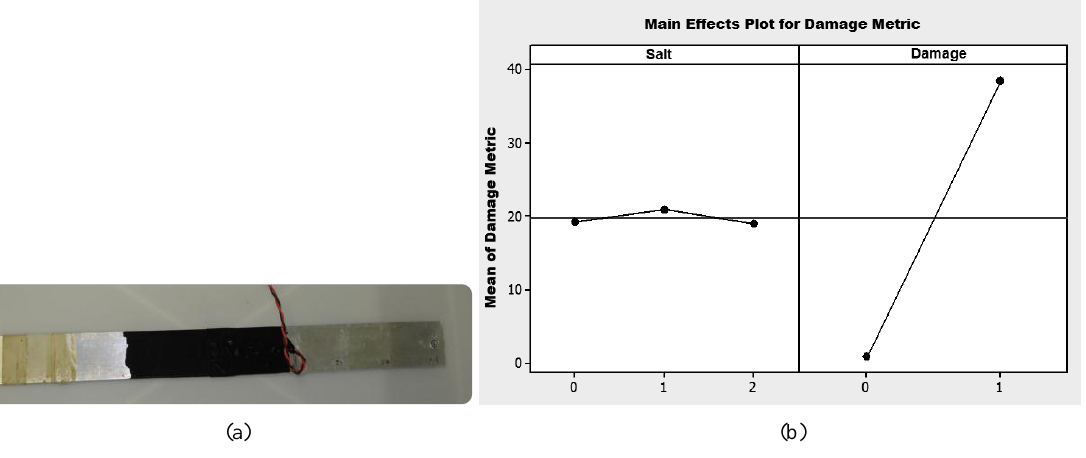
Fig. 11. (a) Shielded PZT patch; (b) Isolated effects of the ionic environment with the shielded PZT